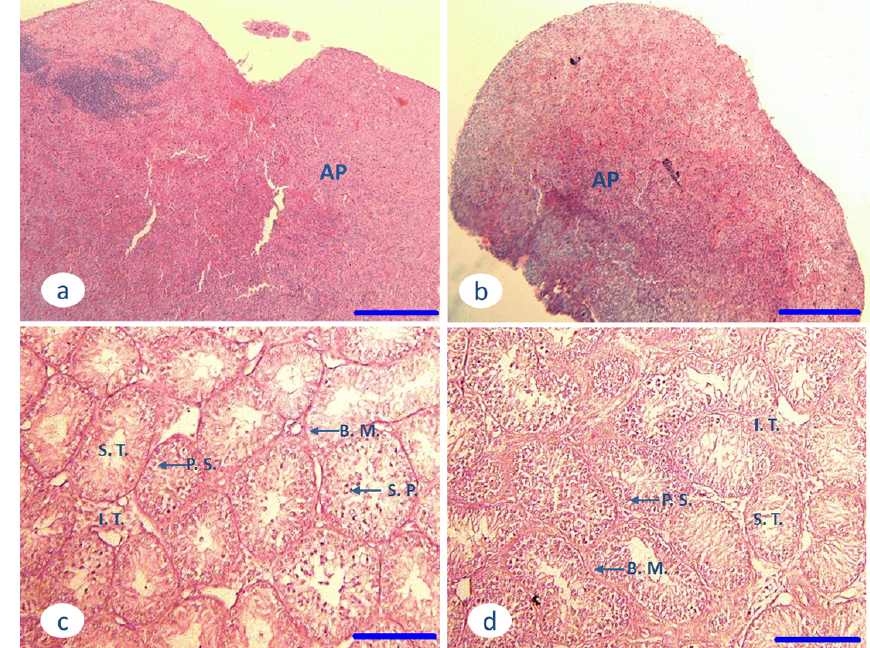
Figure 4. Effects of HS on the histological structure of pituitary and testis in 6-week-old chicks ( n = 6). (a) The pituitary of a chick in the CK group; (b) the pituitary of a chick in the HS group; (c) the testis of a chick in the CK group; and (d) the testis of a chick in the HS group. A. P.: adenohypophysis; S. T.: seminiferous tubule; I. T.: interstitial tissue; P. S.: spermatogenic cell; S. P.: spermatoblast; and